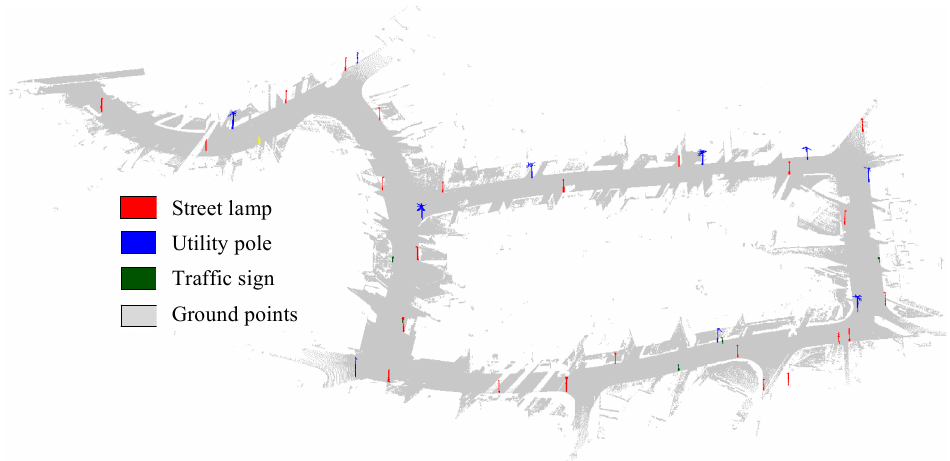
Figure 13. Results of PLO recognition in Data I. Different colors represent the different class.